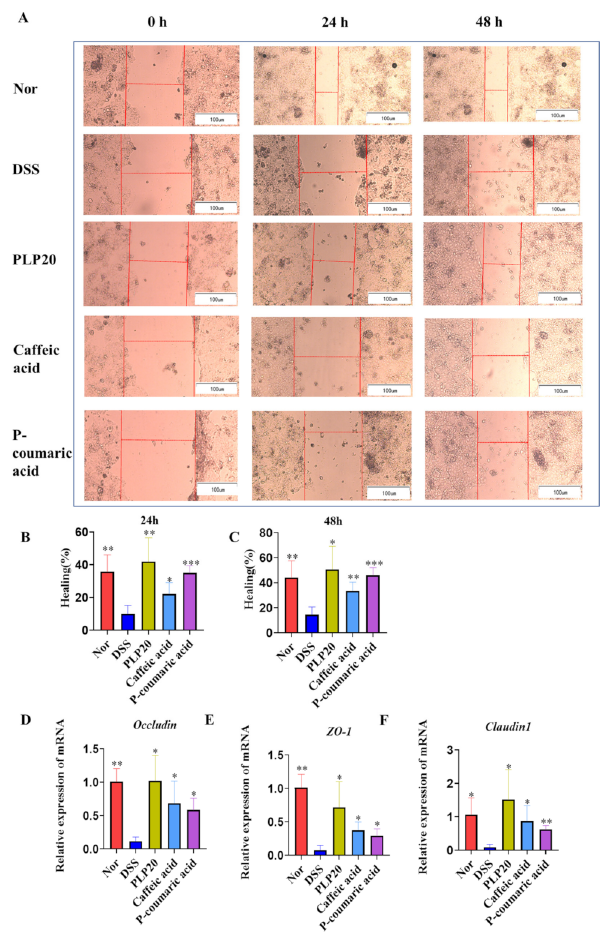
Figure 4. PLP, Caffeic acid, and P-coumaric acid accelerate the wound closure and increase the gene expression of occluding, ZO-1, and clauding1 in Caco-2 cells. Caco-2 cells were stimulated with DSS (3%) and treated with PLPs (20 µ g/mL), Caffeic acid (10 µ g/mL), and P-coumaric acid (10 µ g/mL) ( A – F ). Representative images of scratched areas at 0, 24, and 48 h; bar = 100 µ m (n = 4) ( A ). Percentage of wound healing at 24 and 48 h after scratch (n = 4) ( B , C ). Occludin, ZO-1, and claudin 1 mRNAs were determined by real-time PCR ( D – F ). Nor: normal control cells; DSS: dextran sulphate sodium salt-induced control cells; PLP20: pineapple leaf phenols-treated (20 µ g/mL) DSS-induced cells; Caffeic acid: caffeic acid-treated (10 µ g/mL) DSS-induced cells; P-coumaric acid: P-coumaric acid-treated (10 µ g/mL) DSS-induced cells. Data are expressed as the mean ± SD, and the results ae representative of at least three independent experiments. * p < 0.05, ** p < 0.01, *** p < 0.001 compared to the cells treated with DSS